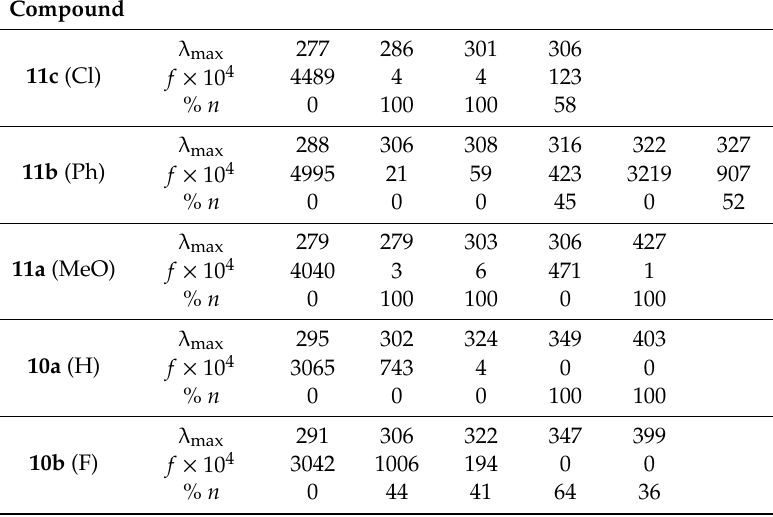
Table 1. The calculated absorption bands ( λ max (nm), oscillator strength, % n → π * character) for 10 and 11